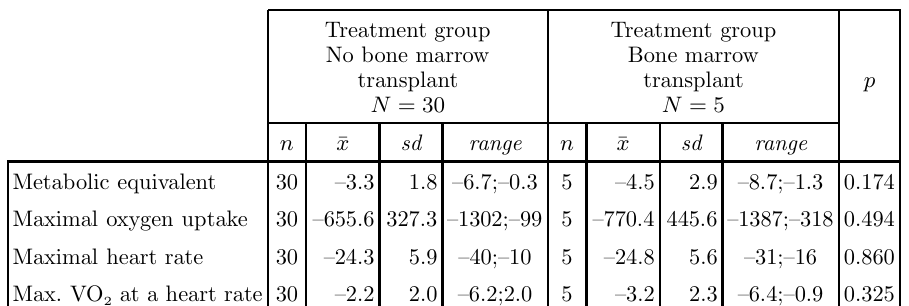
Table 5. Comparisons between two groups (no bone marrow transplant versus bone marrow transplant) for 4 cardiovascular